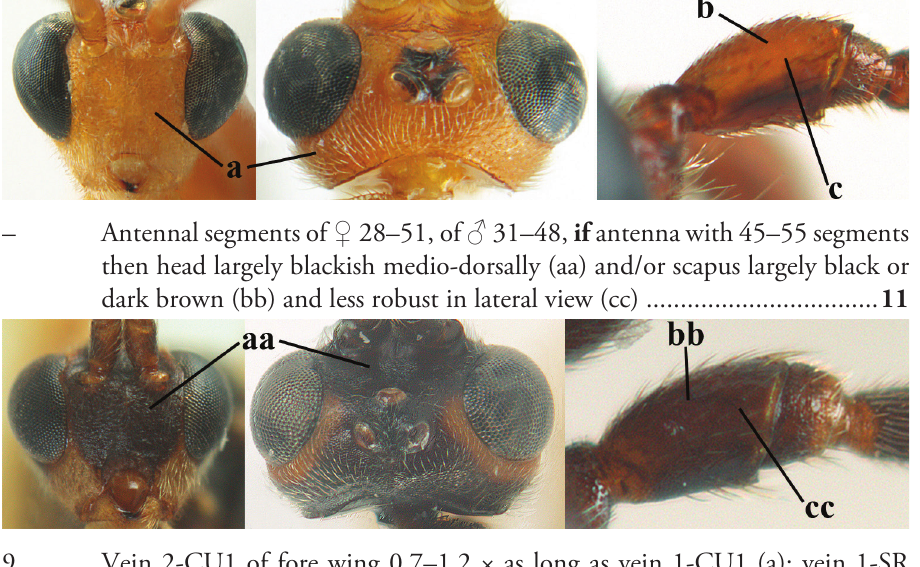
Vein 2-CU1 of fore wing 0.7–1.2 × as long as vein 1-CU1 (a); vein 1-SR weakly angled with vein 1-M (b) and vein 1-M rather curved (c); vein r of fore wing long and subvertical (d); antennal segments of ♀ 56–62; length of fore wing 6–10 mm; [tarsal claws small (e)] .... A. esenbeckii (Hartig,